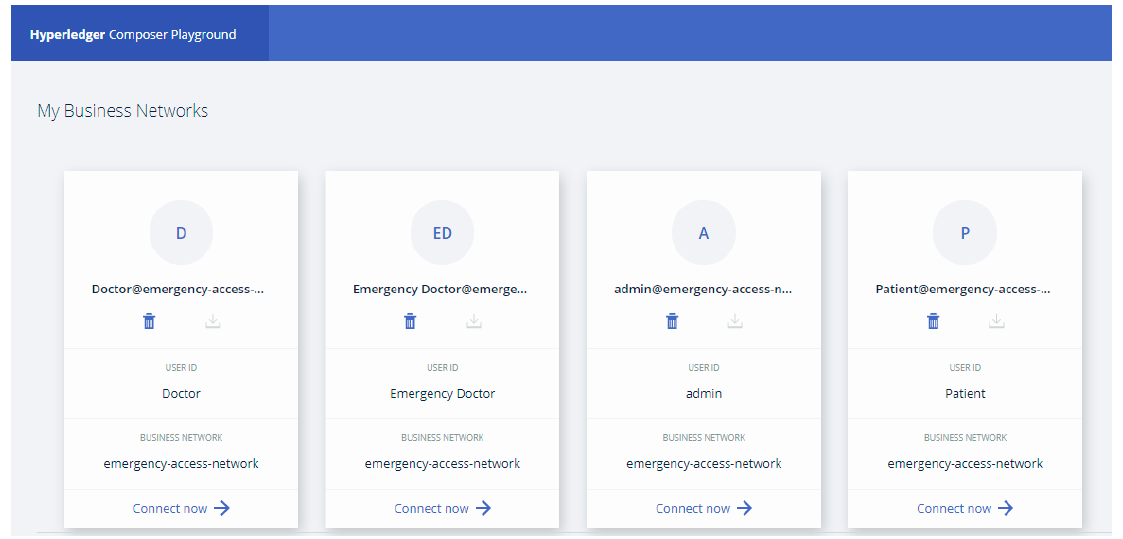
Figure 3. Defined network cards for participants in the hyperledger composer playground.